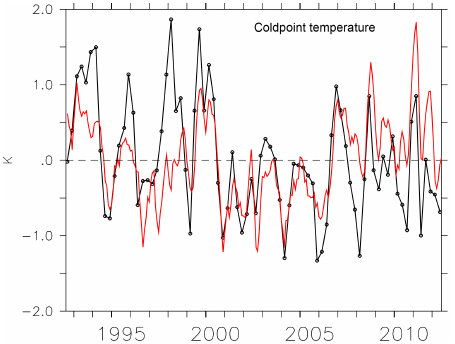
Figure 1. Interannual changes of the near-global mean (60 ◦ S– 60 ◦ N) stratospheric water vapour mixing ratios (in ppmv) at 83hPa. The black line is the data derived from satellite observa- tions (combined HALOE and Aura/MLS satellite measurements, deseasonalized, 3-month average), which were published by Ran- del and Jensen (2013) in their Fig. 5a (upper graph). The red line is the RC1SD simulation (deseasonalized, 3-month running mean). The blue line is the merged data set as published by Heg- glin et al. (2013). The correlation between HALOE/Aura/MLS and RC1SD is r = 0 . 68 and between the merged data set and RC1SD r = 0 . 73. ( r : Pearson’s correlation coefficient, see Appendix B).